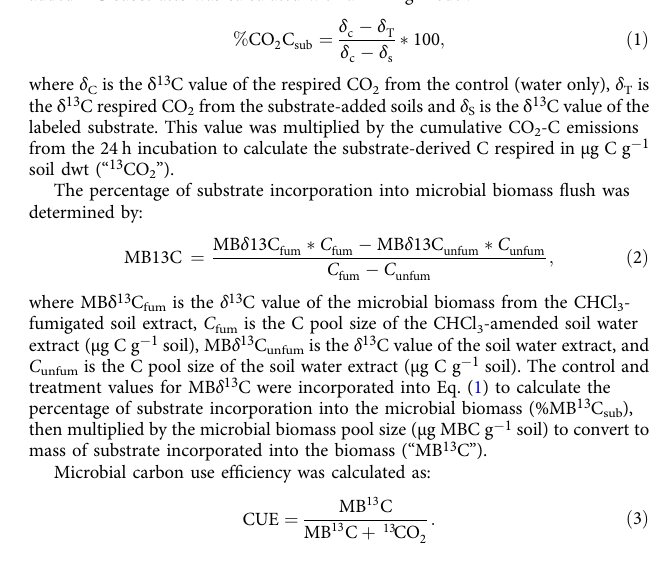
mass of necromass used in each assay were used to calculate δ 13 C of the substrate. Carbon use ef fi ciency assays . We measured growth as the uptake of isotopically- labeled substrate-C into biomass. To examine the effect of simple and complex substrates on carbon use ef fi ciency (CUE), we stabilized soils for 24 h at 15 °C in the dark, then added 1 ml of 13 C-necromass or 13 C-glucose solutions (20 atm%, 0.05 mg C (g fw soil) − 1 ) each to three microcosms (20g fw soil each). Two microcosms were for estimating microbial biomass assimilation of substrate into biomass (50 ml tubes), and one microcosm was for measuring CO 2 production (250ml canning jar fi tted with gas-tight lid and self-sealing rubber septum). We incubated the microcosms for 24 h in the dark at 15°C. To estimate cumulative CO 2 -C production during the incubation, we took four headspace gas samples (5 ml) by syringe and Exetainer ® vial (Labco Ltd., UK) and analyzed their CO 2 concentration on a Perkin-Elmer Autosystem XL gas chromatograph (GC) fi t with a methanizer and fl ame ionization detector. Our fi nal gas sample coincided with the end of the incubation and a fi nal gas sample, which we used for characterizing the δ 13 C signature of the headspace gas on a Picarro G2131-i CRDS isotopic analyzer. Simultaneous with the end of the incubation, we extracted the microbial biomass soil using a modi fi ed chloroform-direct extraction 47 , with a water matrix ( + 1 ml CHCl 3 in one of the tubes). Extracts were aliquoted to two streams for estimating extractable carbon and nitrogen, biomass size and substrate incor- poration: total organic C analysis on a Shimadzu TOC-L CPN (Shimadzu UK Ltd., UK), and freeze-drying, grinding and 13 C analysis on a Costech CN streamed to a Picarro G2131-i CRDS. Reference natural abundance and internal enriched stan- dards were used to calibrate the δ 13 C analysis for both the gas and solid analysis, and enriched sample δ 13 C values (200 – 8000 ‰ ) far exceeded any instrument variability (~0.4 – 5 ‰ ). Soil and DNA analysis . We measured several soil variables to understand controls on CUE. Soil pH was measured with a HI2211 pH meter (Hanna Instruments Ltd., UK) in a 1:2 (soil:water) slurry. Texture was measured gravimetrically using a hydrometer and cylinder, after removing organic matter (30% H 2 O 2 ) and carbo- nates (0.5 M NaOAc). Total C and N were measured on ground samples using a Truspec CN analyzer. Olsen-P was determined colorimetrically 48 . DNA was extracted from 0.25 g of soil per replicate soil core using PowerSoil-htp 96-well DNA Isolation kit (Qiagen) according to manufacturer ’ s protocols. A dual indexing protocol 49 was used for Illumina MiSeq sequencing of the V3 – V4 hypervariable regions of the bacterial 16S rRNA gene using primers 341F 50 and 806R 51 ; and the ITS2 region for fungi using primer ITS7f and ITS4r 52 . Each sample ’ s amplicon concentrations were normalized using SequalPrep Normalization Plate Kit (Thermo Fisher Scienti fi c) prior to sequencing on the Illumina MiSeq using 600 cycle V3 chemistry. Fungal ITS sequences were processed using PIPITS 53 with default parameters. Bacterial sequences were processed using PEAR (sco.hits.org/ exelixis/web/software/pear) for merging forward and reverse reads, quality fi ltered using FASTX tools (hannonlab.cshl.edu), chimera checked with VSEARCH_- UCHIME_REF and clustered to 97% OTUs with VSEARCH_CLUSTER (github. com/torognes/vsearch). After processing, the number of amplicon sequence reads per sample was 28205 for 16S rRNA gene and 40406 for ITS2 region. Calculation of carbon use ef fi ciency . The percentage of CO 2 -C derived from the added 13 C substrates was calculated with a mixing model: